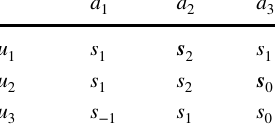
Table 1 IFLC ( U , A , { S , ⋄ } , R ⋄ )